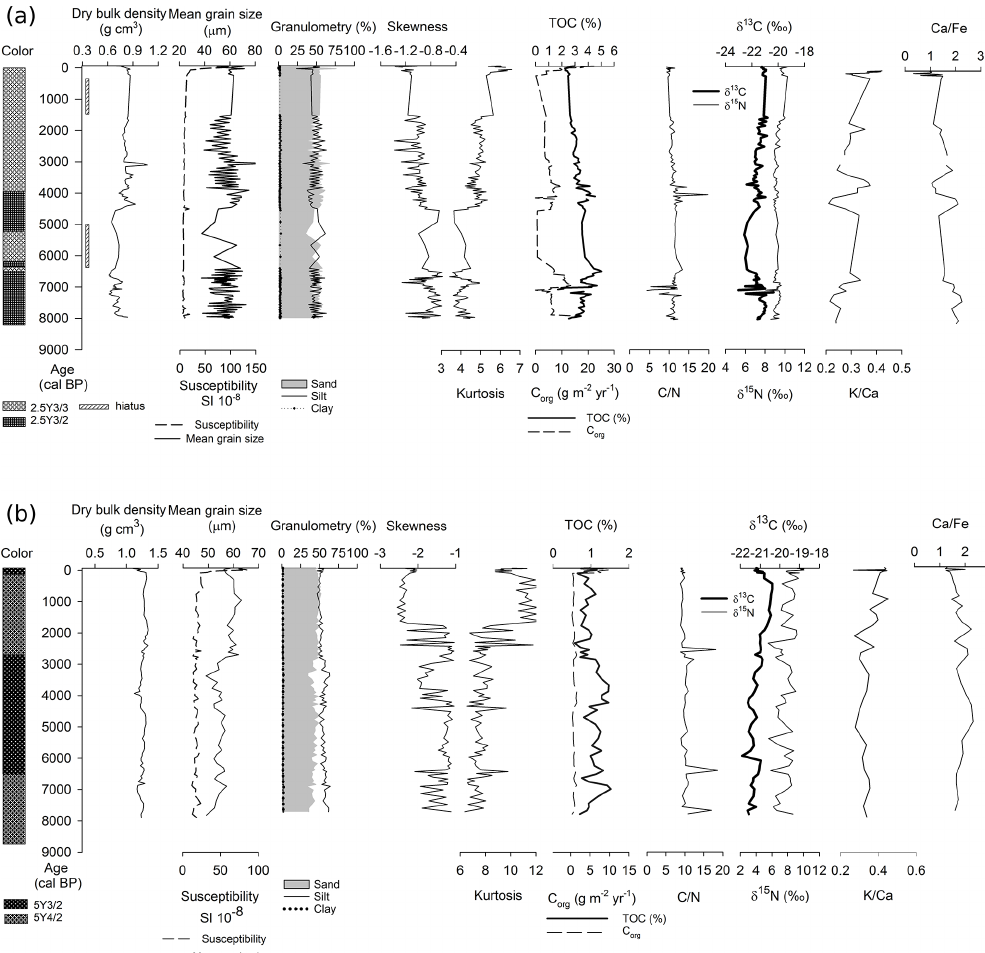
Figure 5. Characterization of sediment cores retrieved from (a) Guanaqueros Bay (BGGC5) and (b) Tongoy Bay (BTGC8), where the color (Munsell chart scale) represents the depth, dry bulk density, mean grain size, granulometry (percentage of sand, silt and clay), statistical parameters (skewness, kurtosis), organic components (TOC, C / N ratio, stable isotopes δ 15 N and δ 13 C) and chemical composition (K / Ca, Ca /